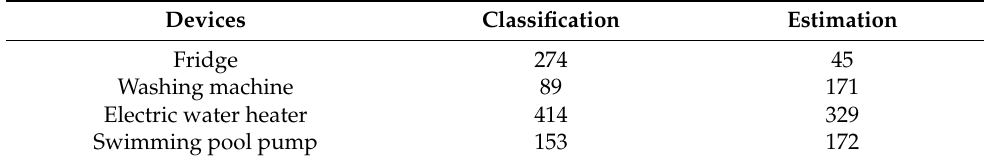
Table 4. Dimensions of non-dominated sets.